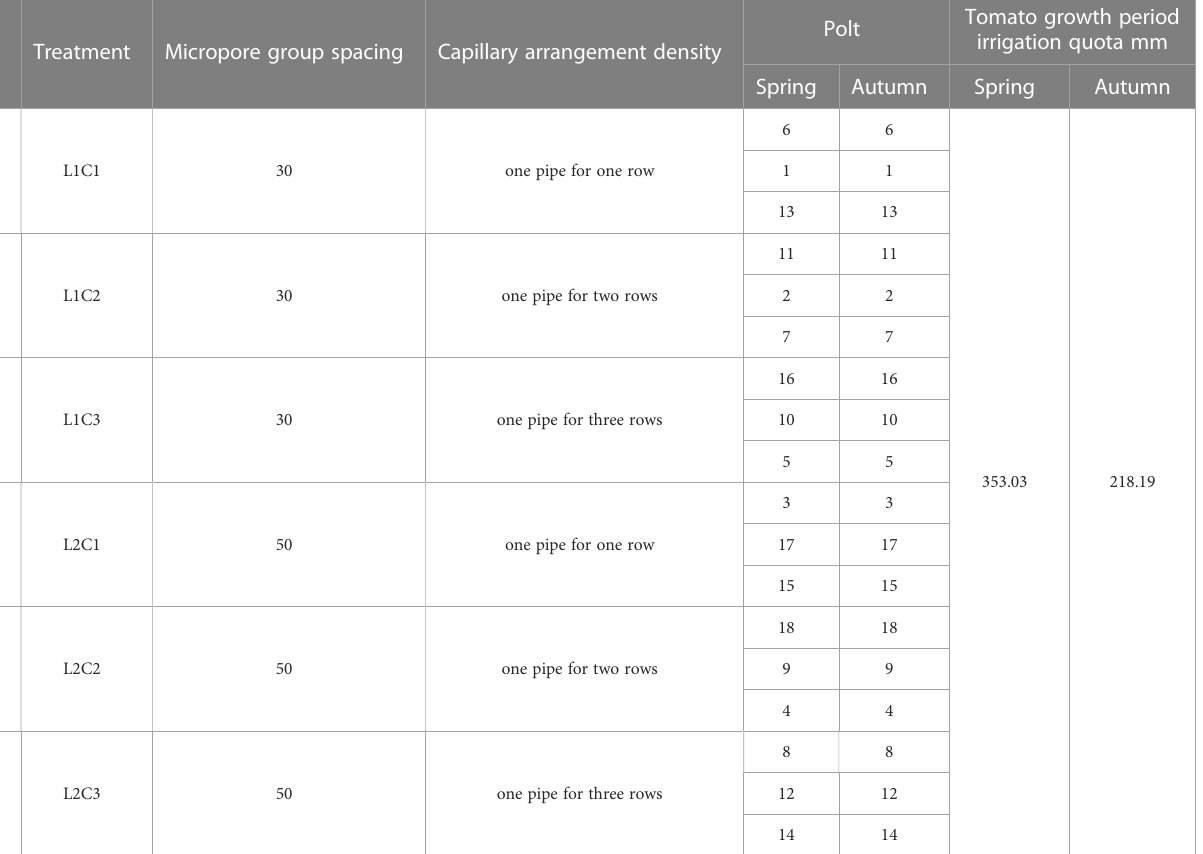
TABLE 1 Experimental design.